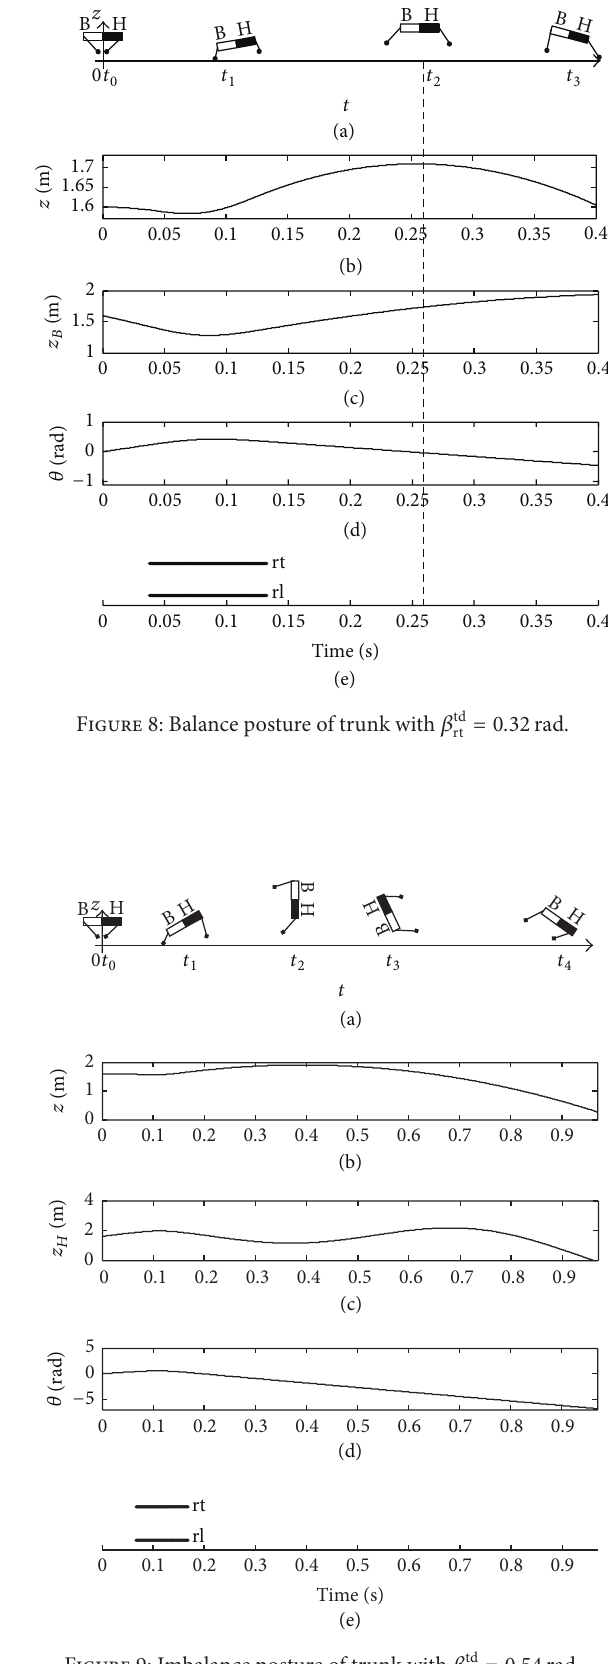
Figure 9: Imbalance posture of trunk with 𝛽 td rt = 0 . 54